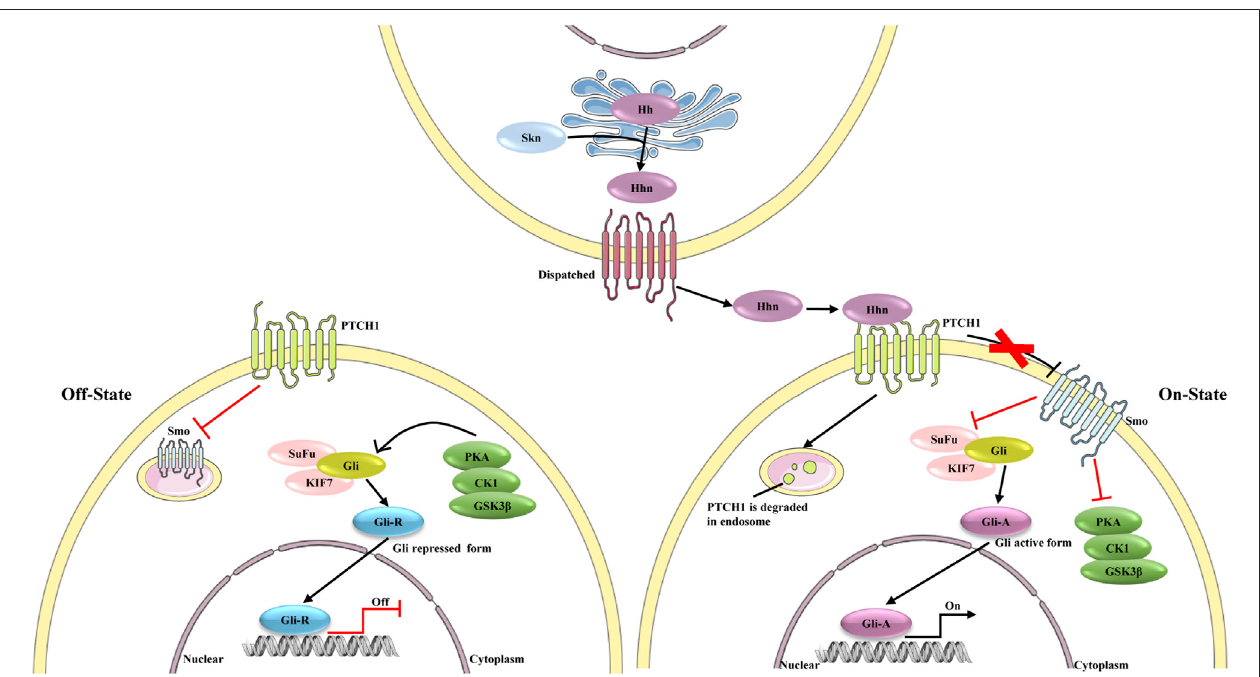
FIGURE 4 | The different state of hedgehog signaling pathway. In the absence ofligands, the signaling is on “ Off state ” , PTCH1 inhibits the activity of Smo. Protein kinase(includingPKA,CK1andGSK3 β ),SuFuandKIF7phosphorylateGli,whichleadsproteolyticcleavageofGlitoGli-repressor(Gli-R).Gli-Rrepressestheexpression of target genes. In Hhn secreting cells, the precursor of Hh is auto-cleaved and can be modi fi ed by a cholesterol at C-terminus to form Hhn on ER membrane. After this process, Hhn is secreted from the secreting cells and bind to PTCH1. PTCH1 is degraded in endosome, and consequently Smo repression is removed. Activated Smo inhibits the effect of PKA on Gli proteins, leading to the dissociation of SuFu, and Gli active form (Gli-A) is formed. Gli-A promotes the expression of target genes.